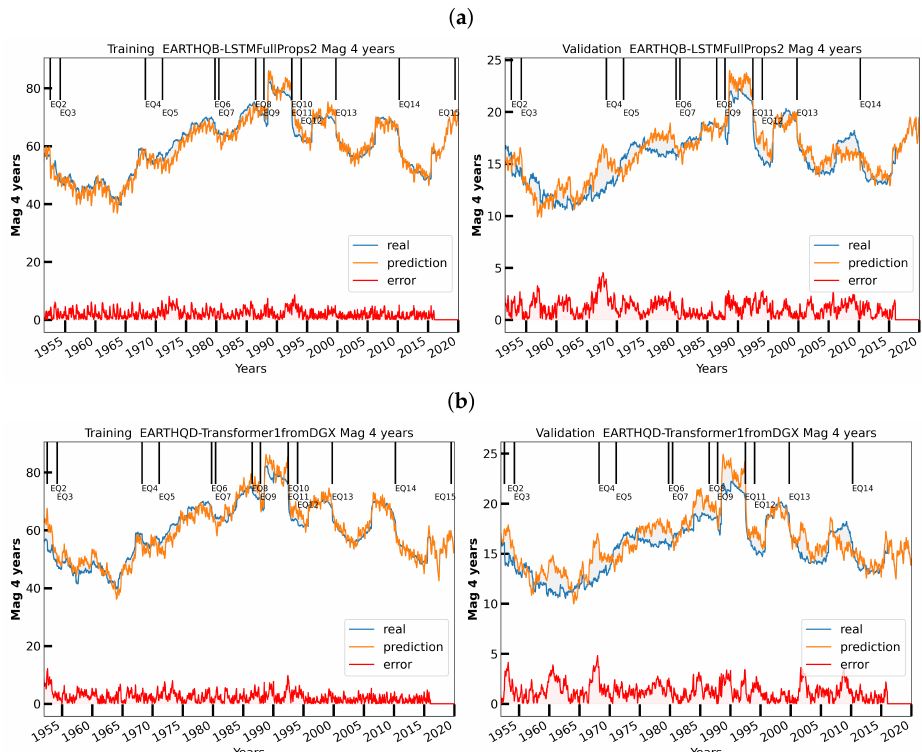
Figure 19. Four-year m bin ( F : ∆ t , t ) results for ∆ t = 208 weeks (training on left, validation on the right) are given for 2 methods (TFT not available). The earthquakes marked are listed in Table 1. ( a ) Four-year LSTM results for m bin ( F : ∆ t , t ) for ∆ t = 208 weeks. ( b ) Four-year science transformer results for m bin ( F : ∆ t , t ) for ∆ t = 208